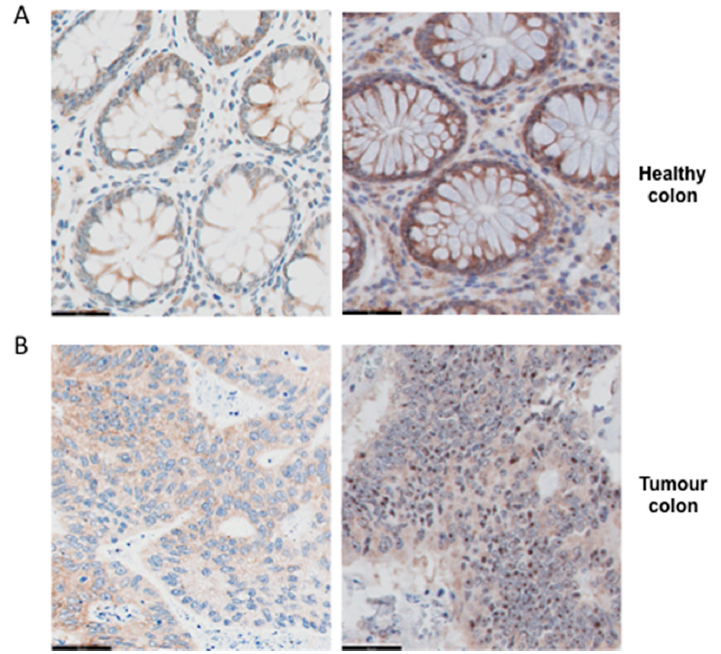
Figure 3. Different locations of PKR in healthy colon tissues and tumour tissues. ( A ) Representative immunohistochemical detection of total PKR in healthy colon tissues. PKR immunostaining was weak (first panel) or strong (second panel), but was mostly located in the cytoplasm of cells. Scale bar, 50 μ m. ( B ) Representative immunohistochemical detection of total PKR in tumour colon tissues. PKR immunostaining was mostly located in the cytoplasm of cells (first panel); however, in several tumours, PKR was located heavily in the nucleolus (second panel). Scale bar, 50 μ m.